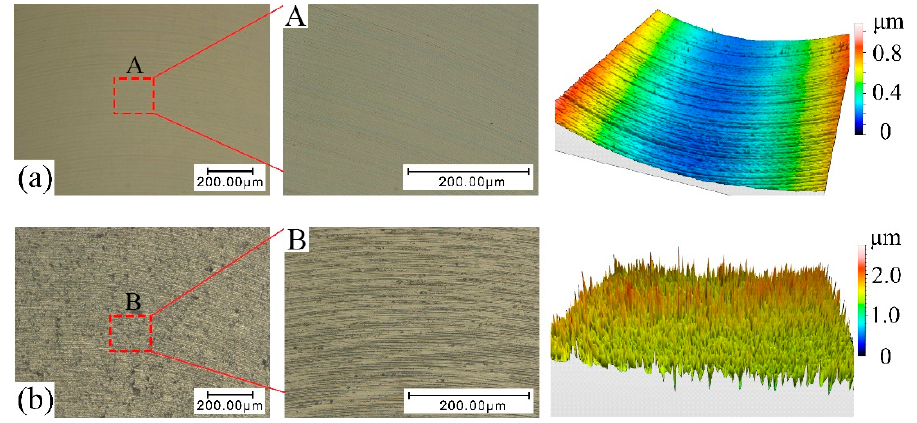
Figure 3. Selected machined surface topographies and three-dimensional morphology features at various cutting conditions. ( a )—Test 2; ( b )—Test 8.